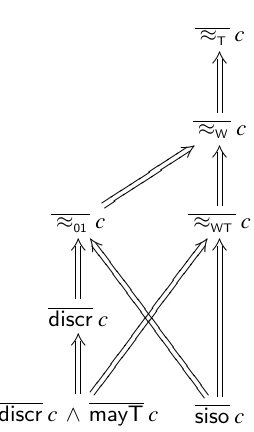
Figure 5: Simplified implication graph of security